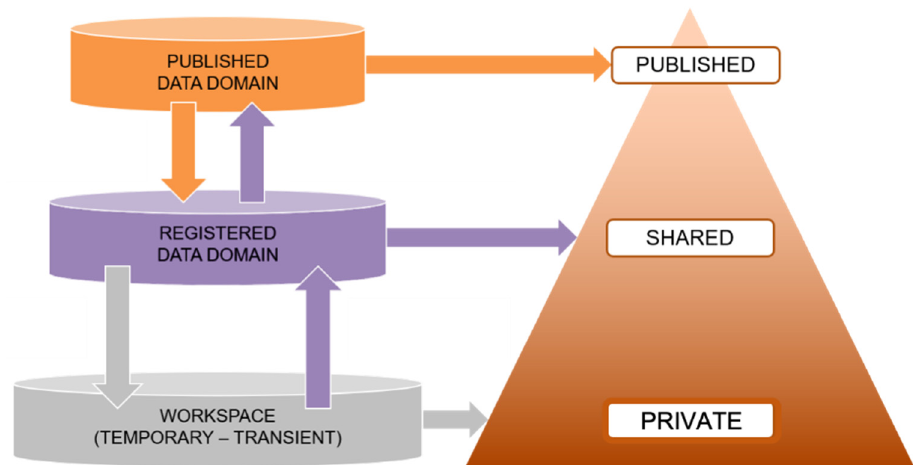
Figure 1. Layers of data with some data being published, more being shared for reuse in labs and collaborations, and a large amount residing in transient storage.